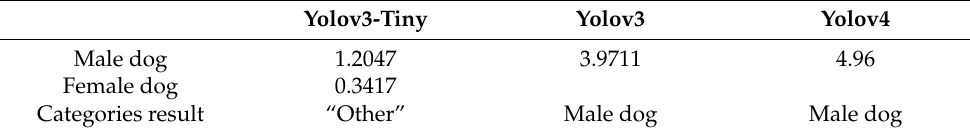
Table 7. Classification results of male dog images by the majority voting algorithm.